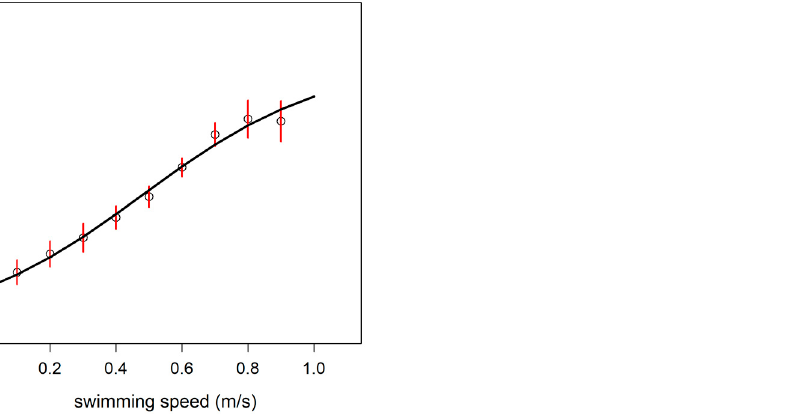
Figure 2. Logistic model of oxygen consumption rate (MO 2 ) as a function of the swimming speed (n = 9 fish) in rainbow trout ( Oncorhynchus mykiss ). Circles with the red error bars indicate the observed mean ± standard error values, while the black line represents the prediction of the MO 2 by the model. The estimated parameters of the logistic model were as follows: A sym = 668.69 ± 134.4; x mid = 0.48 ± 0.13; scal = 0.28 ± 0.07. Table 2. Summary of the parameters and statistics relative to the estimates of the different models, including the oxygen consumption rate during U crit , the muscular activity (red and white), and the calibration of the oxygen consumption rate with accelerometer tag in rainbow trout ( Oncorhynchus mykiss ). Estimate, standard error and associated t and p values were provided for each parameter of each model. Parameters Estimate St.